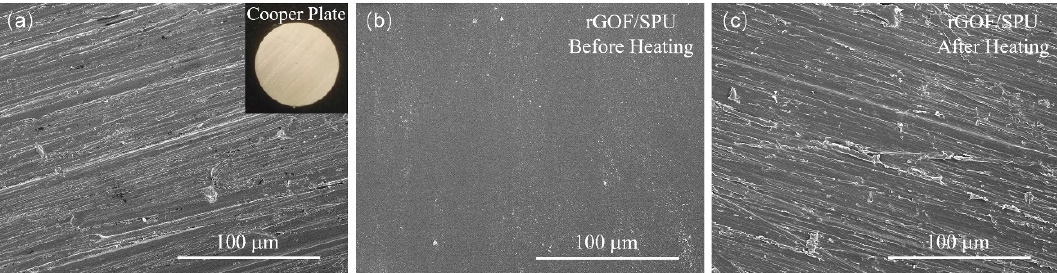
Figure 6. SEM images of the surfaces of the copper plate ( a ) and the rGOF/SPU composite before ( b ) and after ( c ) heating.